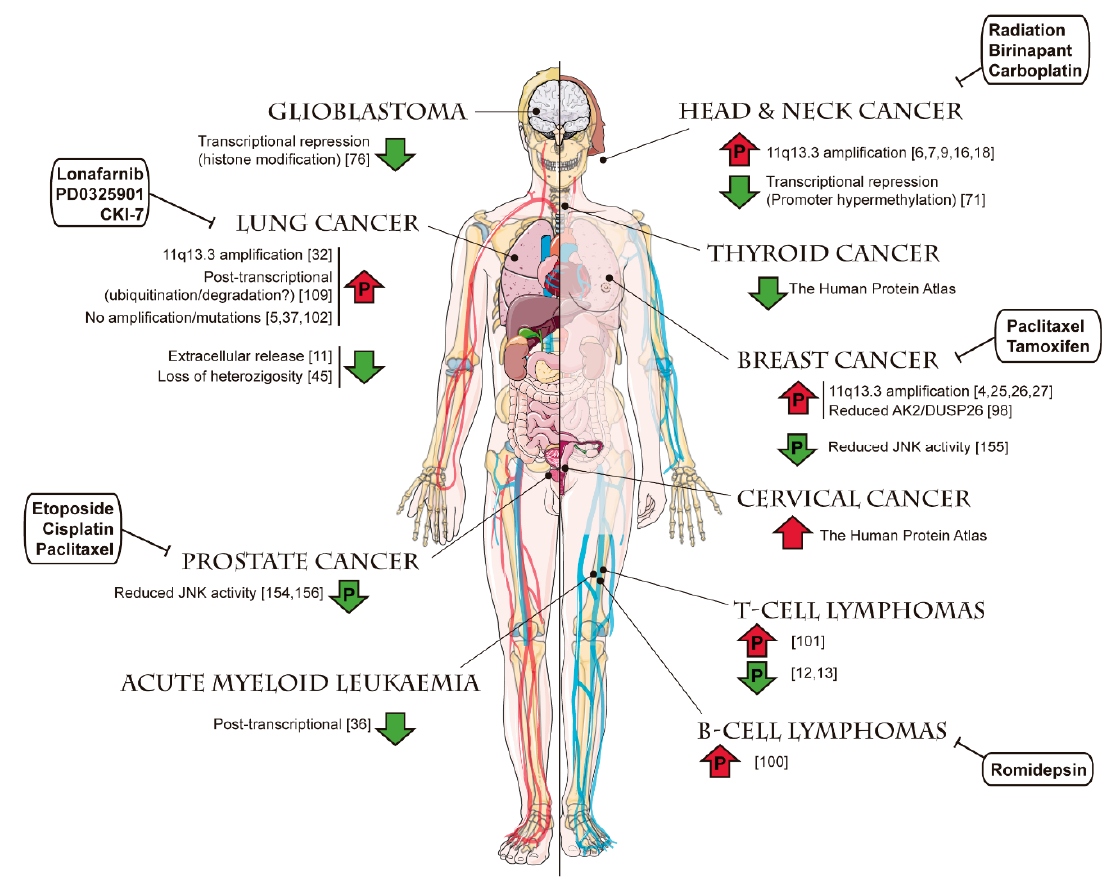
Figure 9. Alterations of FADD levels reported in different cancer types. For each tumor type, reported evidence of an increase (upwards red arrow) or a decrease (downwards green arrow) of FADD levels is shown, indicating the underlying mechanism when this information is available (references indicated in brackets). Arrows including a “P” indicate changes also affecting the levels of phosphorylated FADD. Anticancer therapies reported to target FADD in certain tumor types are shown in white boxes, and their mechanisms of action are detailed in Figure 10. Templates to build this figure were obtained from SMART Servier Medical Art (Attribution 3.0 Unported, CC BY 3.0).